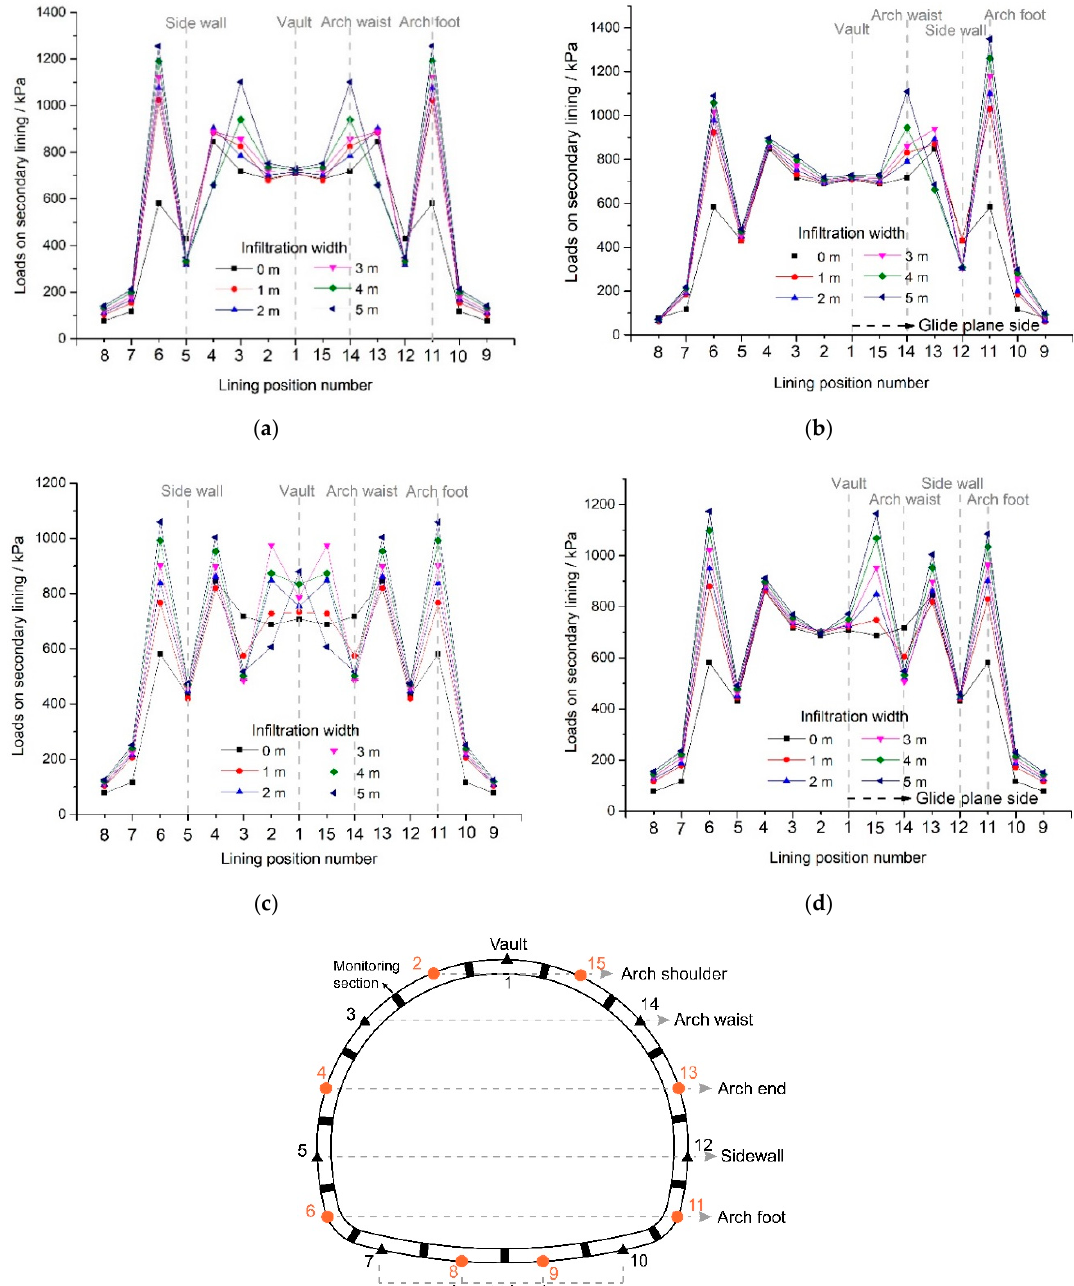
Figure 14. Load distribution under the effect of slide surface immersion [19]. ( a ) Case 1, ( b ) Case 2, ( c ) Case 3, ( d ) Case 4, and ( e ) Load monitoring points.